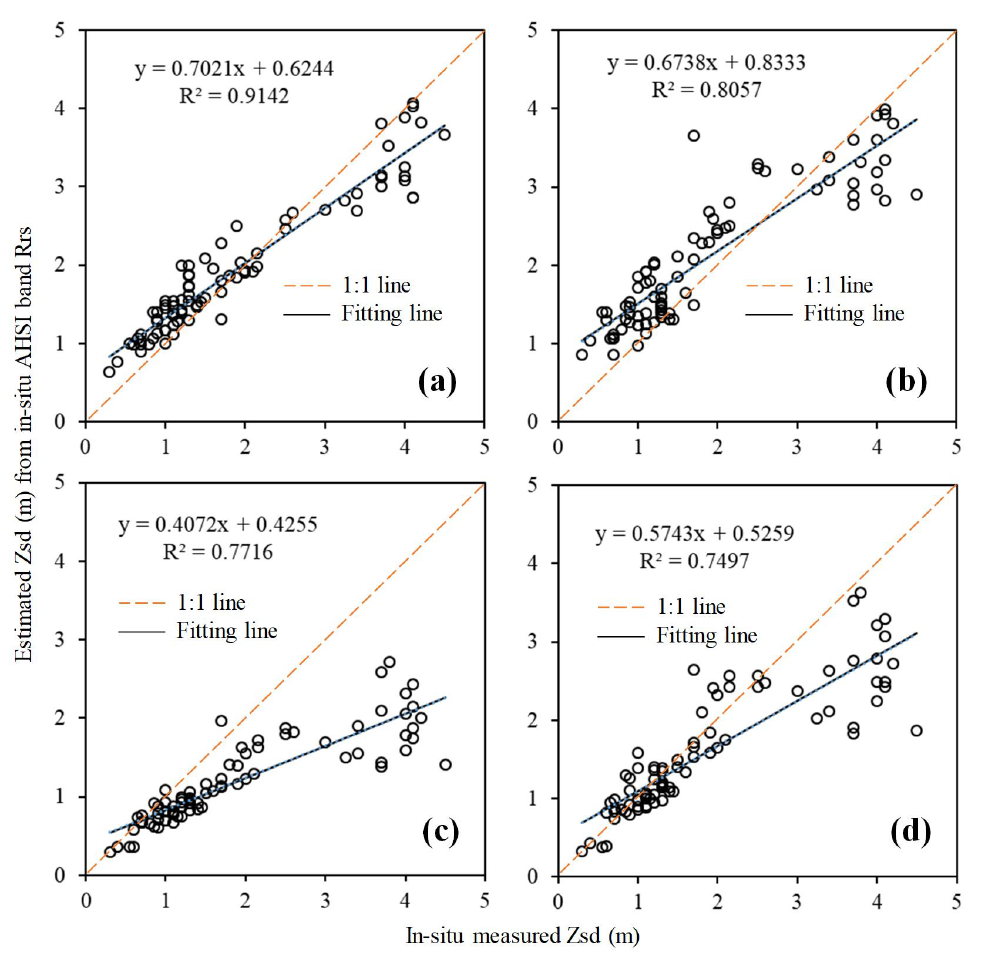
Figure 3. Estimated Z sd from the AHSI band-equivalent in situ R rs of 84 samples, based on semi-analytical methods using various QAA algorithms: ( a ) QAA V 5 , ( b ) QAA V 6 , ( c ) QAA L 09 , and ( d ) QAA M 14